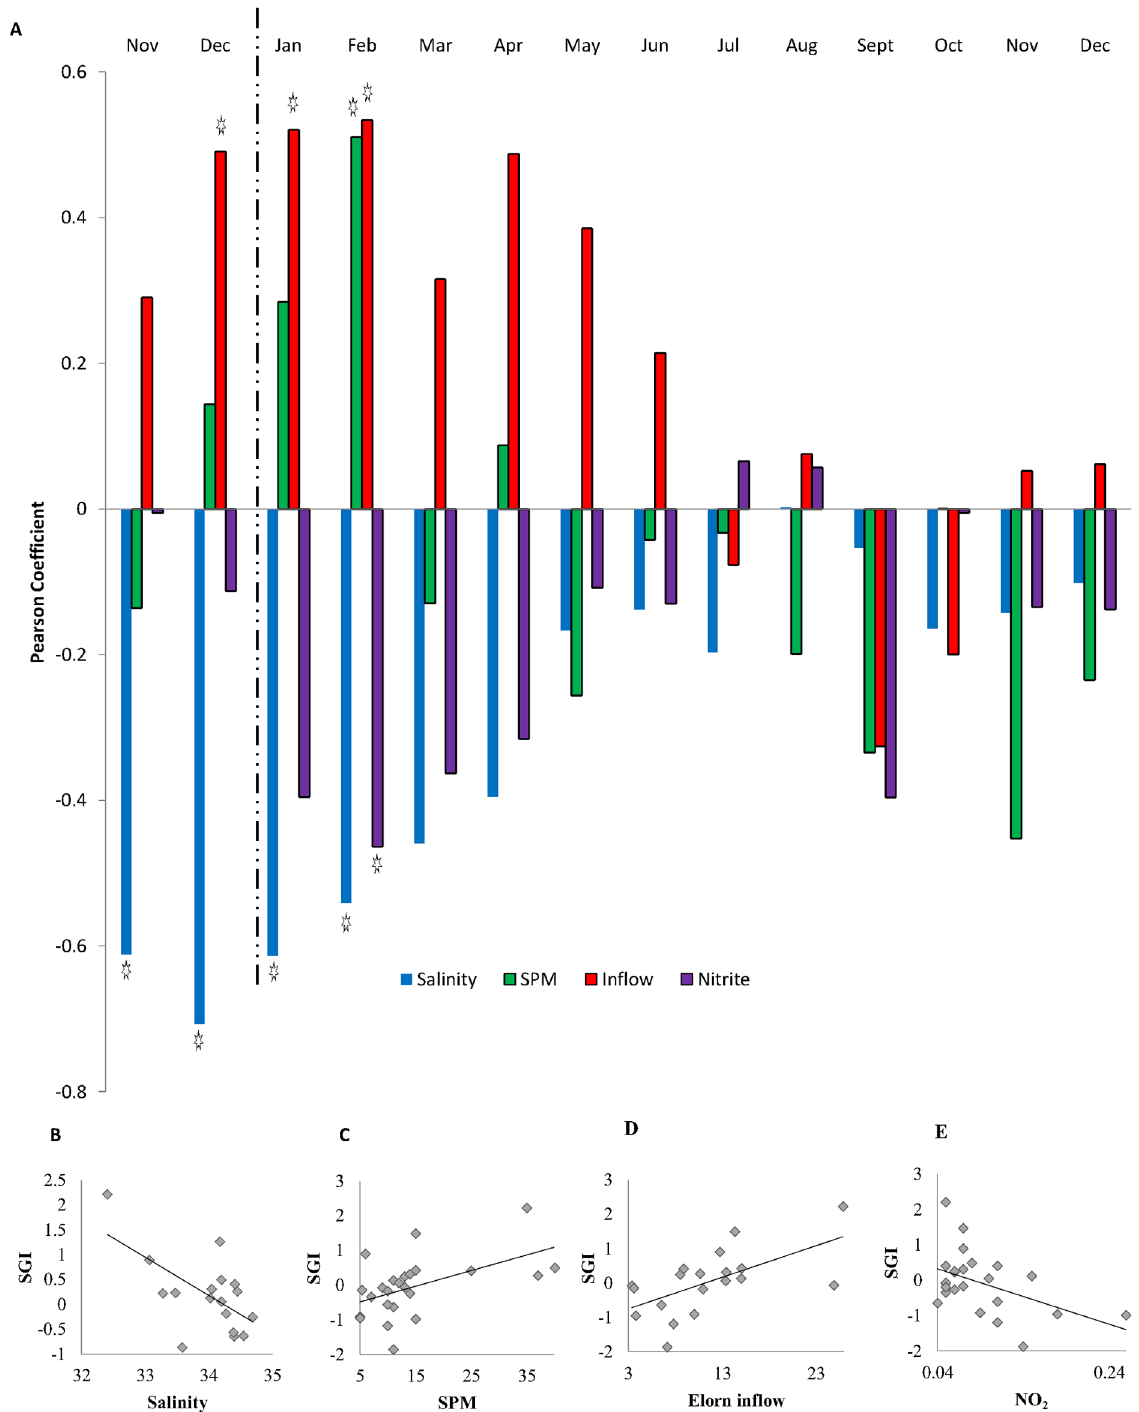
Fig 5. Comparison of chronology with environmental data. A) Pearson correlation coefficients of monthly environmental data with the SGI. Significantcorrelations (p < 0.05) are marked with a star. Dotted line indicatesthe changebetweenyears (e.g. previousand current year). B-E) biplotsof significantenvironmental data (averagedmonthly) and the chronology.